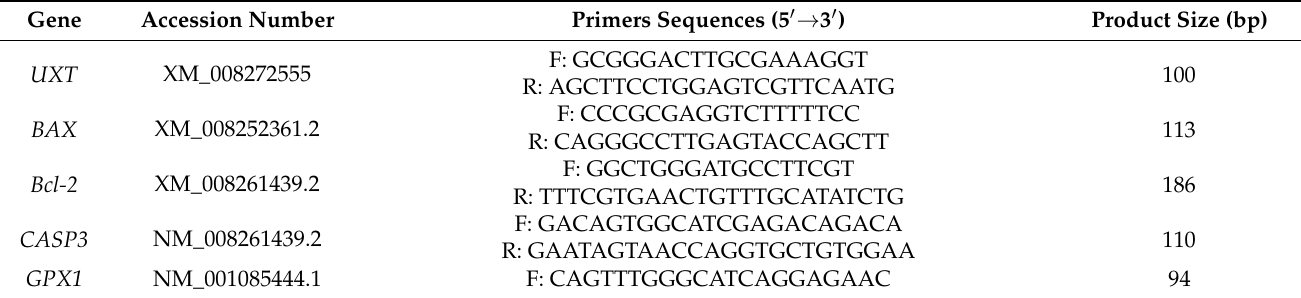
Table 1. Primers used for quantitative real-time PCR analysis of gene expression according to Imbabi et al. [43].